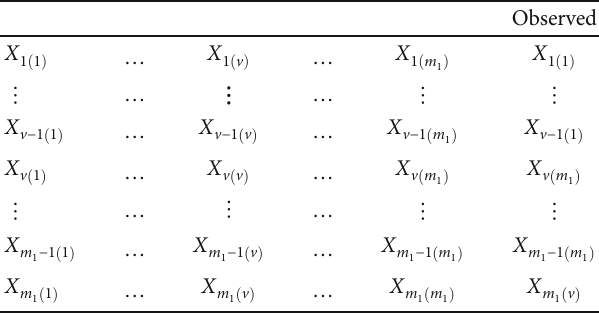
Table 1: The observed ERSS with OSZ.